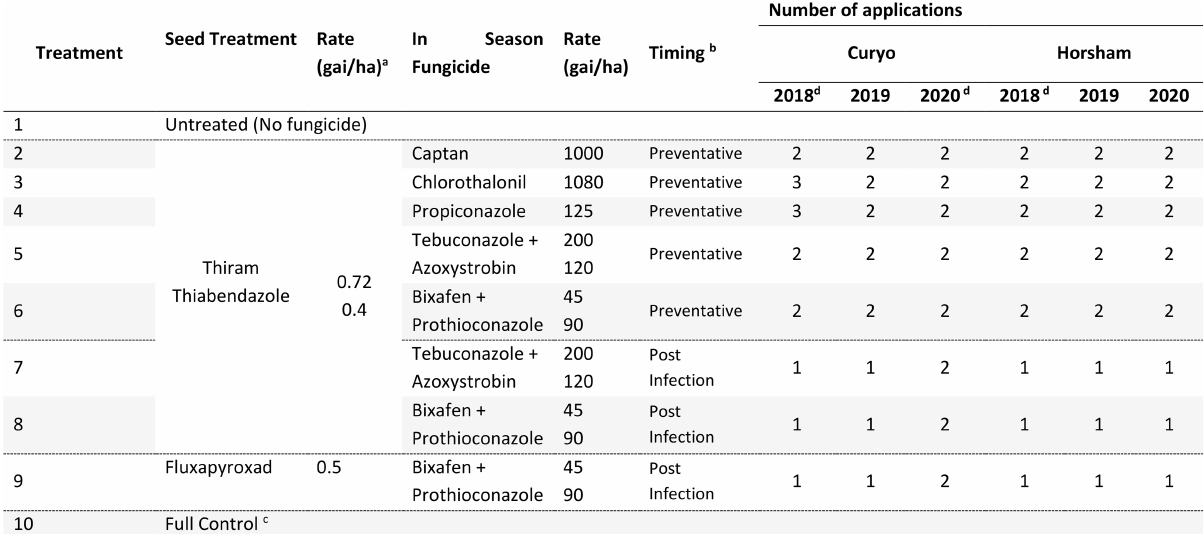
TABLE 2 Fungicide treatments and the number of applications applied for each treatment to assess control of Ascochyta blight (AB) in chickpea at Curyo and Horsham during 2018–2020.